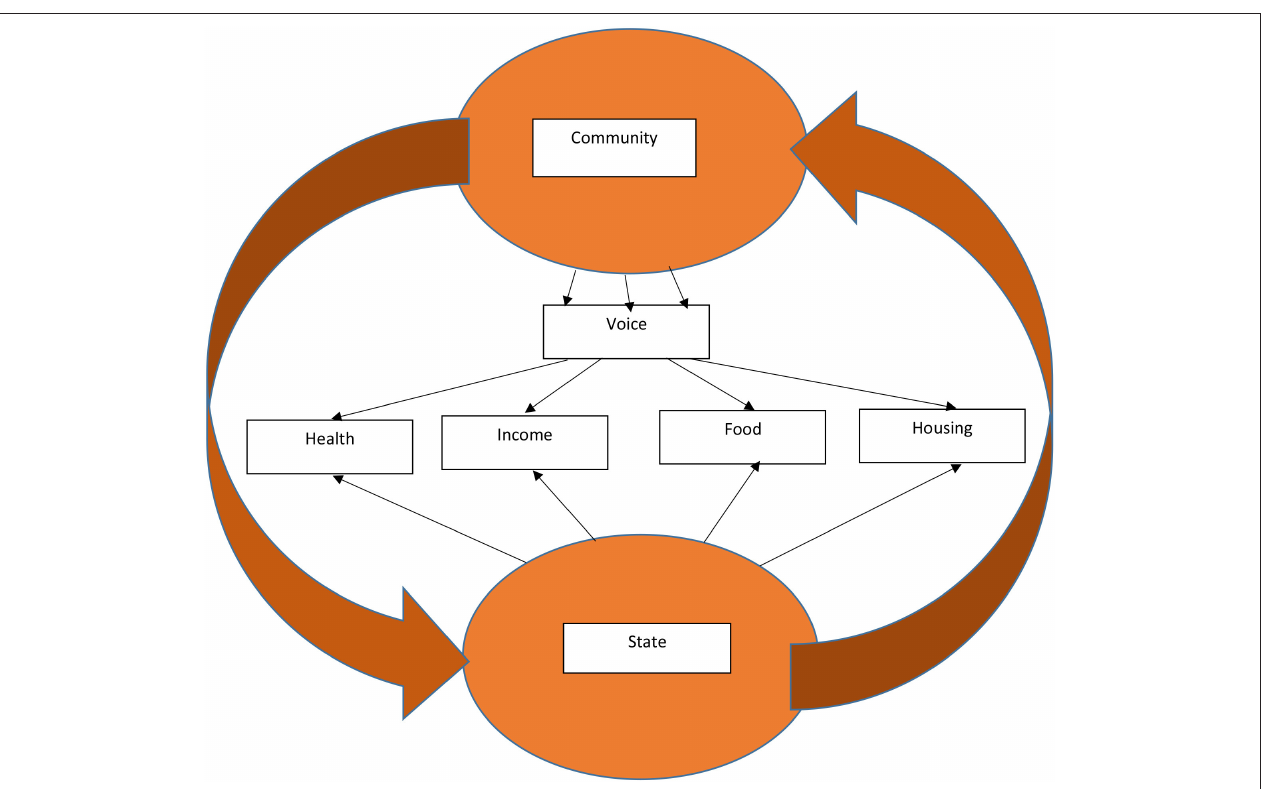
FIGURE 1 | Community-state interaction in constituting COVID-19